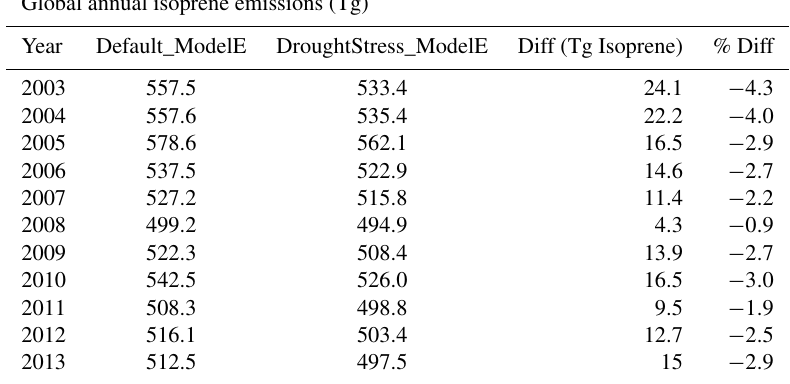
Table 2. Global annual Tg of isoprene (2003–2013). Global annual isoprene emissions